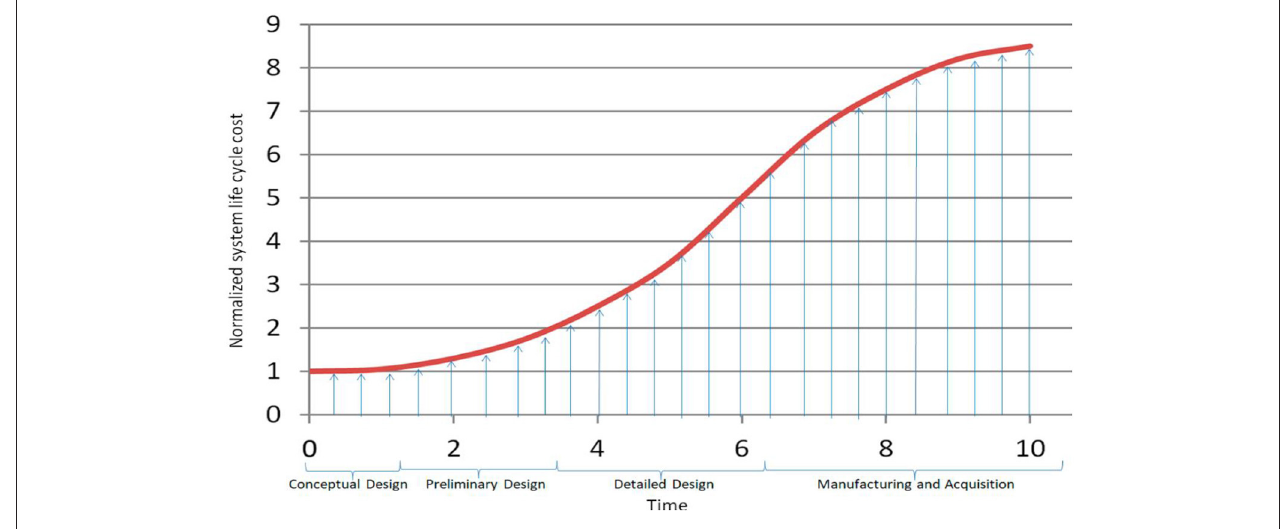
FIGURE 15 | Common SE curve system life cycle cost (LLC vs. Time).